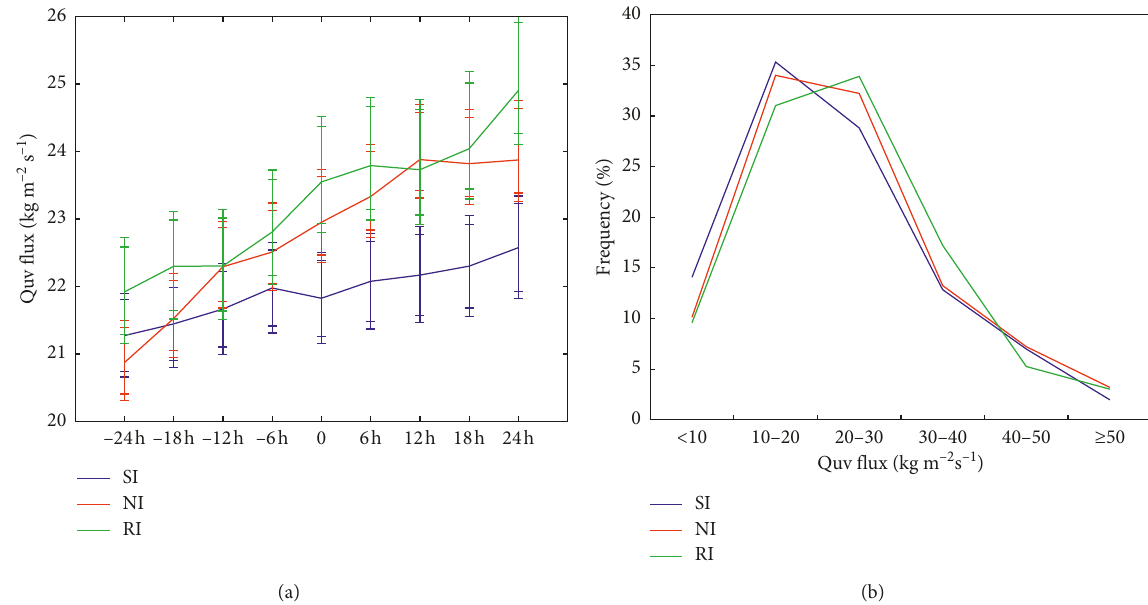
Figure 10: (a) As in Figure 7, but for net moisture inflow (kg m − 2 s − 1 ). (b) As in Figure 8, but for net moisture inflow.